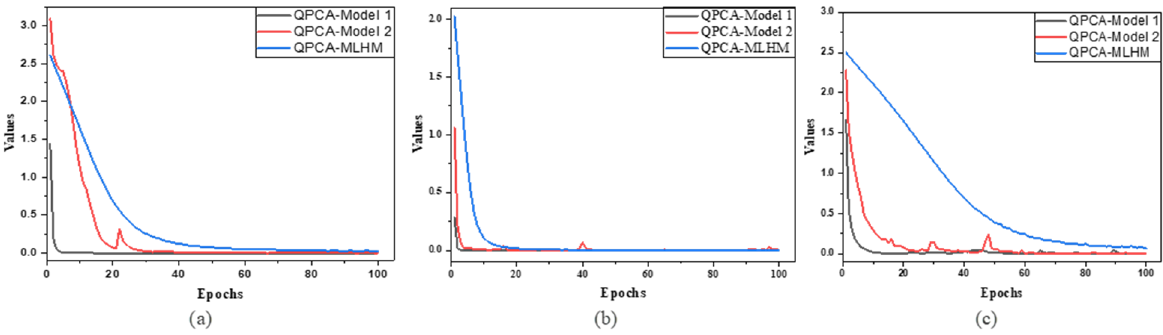
Figure 7. Loss values of the three datasets for the two models of Level-0 (QPCA-Model 1 and QPCA- Model 1) and Level-1 model (QPCA-MLHM). ( a ) is the loss values of the IPs dataset, ( b ) is the loss values of the Pavia-University dataset, and ( c ) is the loss values of the Kennedy Space Center da- taset.